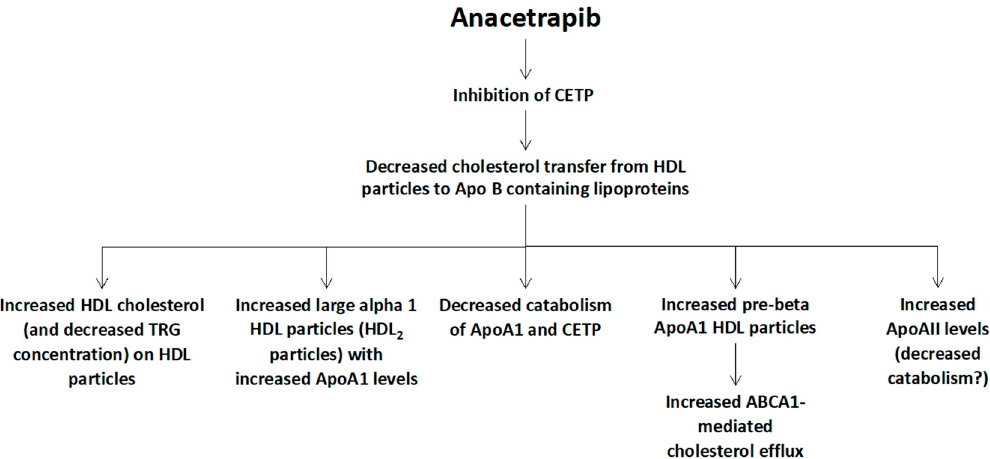
Figure 3. Potential mechanisms of anacetrapib-mediated changes of high-density lipoprotein (HDL) metabolism. CETP: cholesteryl ester transfer protein, Apo: apolipoprotein, TRG: triglycerides, ABCA1: ATP-binding cassette transporter ABCA1 (member 1 of human transporter sub-family